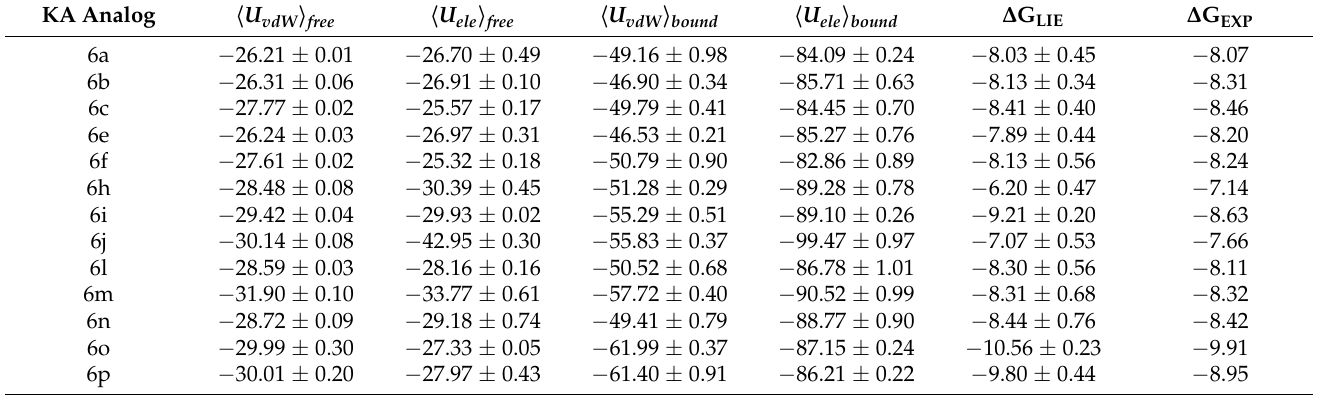
Table 3. LIE-calculated ( ∆ G LIE ) and experimental ( ∆ G EXP ) binding free energies of KA analogs in complex with TYR Bm . All values are reported in